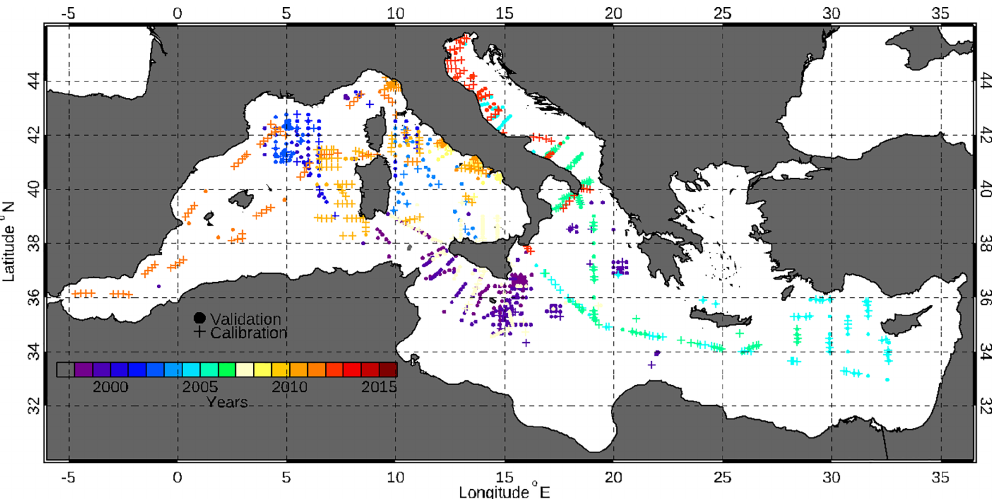
Figure 1. Study area and space–time distribution of the in situ MedBiOp dataset (1997–2016) used in this work. Dots identify the in situ stations used as sea-truth for satellite data validation, whereas crosses refer to the observations used to develop the regional OC algorithms. Table 1. Overview of the available wavelengths from VIIRS, MODIS, MERIS, OLCI, and SeaWiFS sensors, those used to produce the REP dataset (available from PML), and those collected in situ. Target wavelengths of the band-shifting procedure are highlighted in grey. The column “in situ” refers to the bands of the Lu, Ed, and Es Satlantic radiometers used to compute the algorithm functional forms and described in the text (The Mediterranean Sea in situ bio-optical dataset: MedBiOp). To allow for a full satellite to in situ data comparison, the in situ data that are not directly measured (bands without the “x”) are computed via band shifting. Wavelength (nm) Sensors REP In situ VIIRS MODIS MERIS OLCI